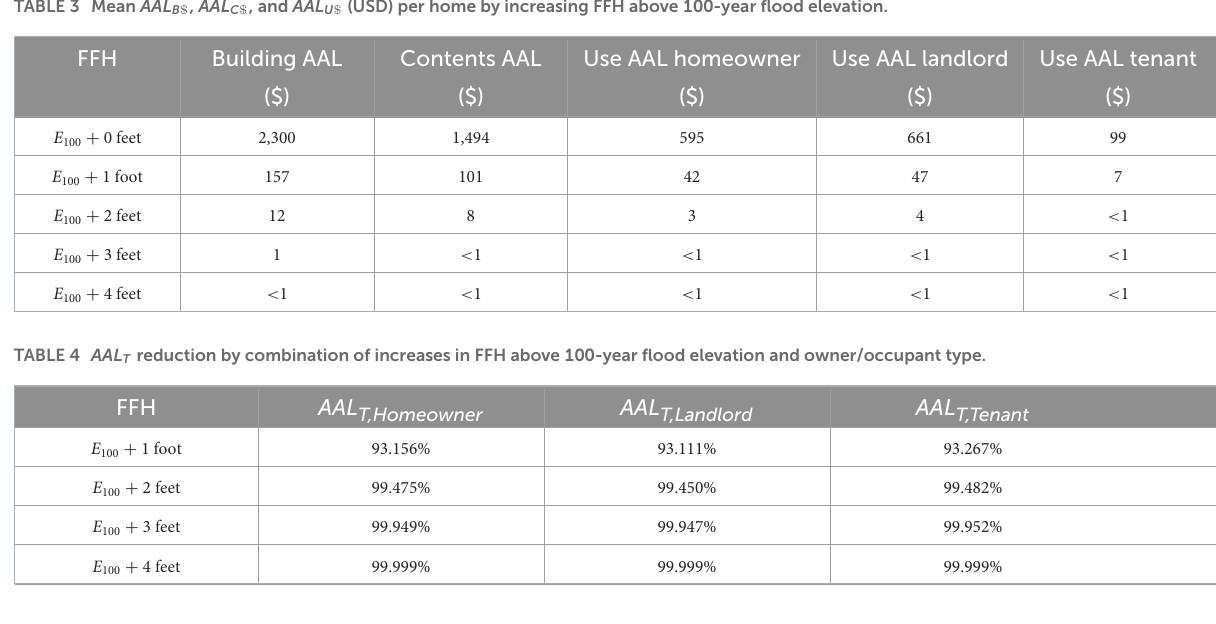
TABLE 3 Mean AAL B $ , AAL C $ , and AAL U $ (USD) per home by increasing FFH above 100-year flood elevation.